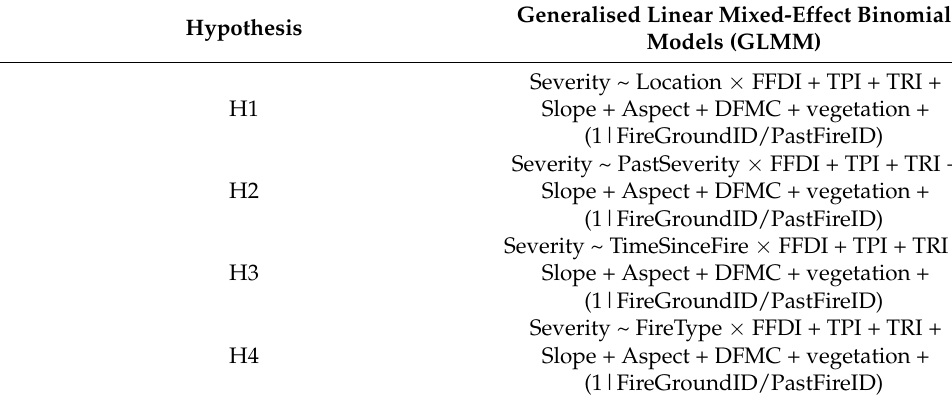
Table 1. Outline of models used to test hypotheses about the impacts of antecedent fire severity and fire type on fire severity during the 2019–20 fire